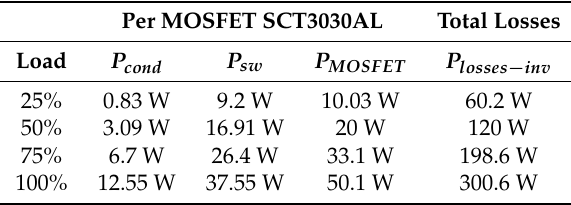
Table 3. Losses calculated for the inverter operating at 101.34 kHz switching